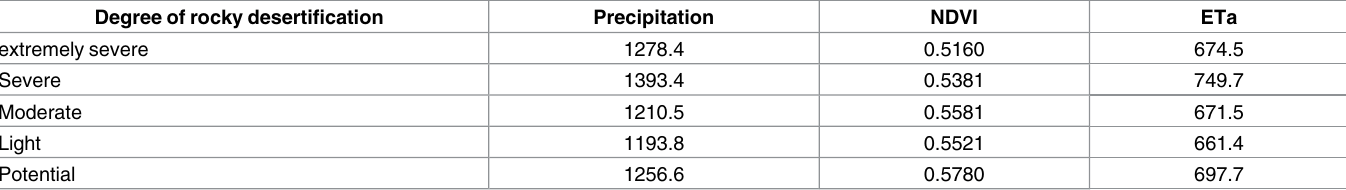
Table 4. Mean values of the average precipitation, NDVI, and ETa in different severity categories of rocky desertification areas.